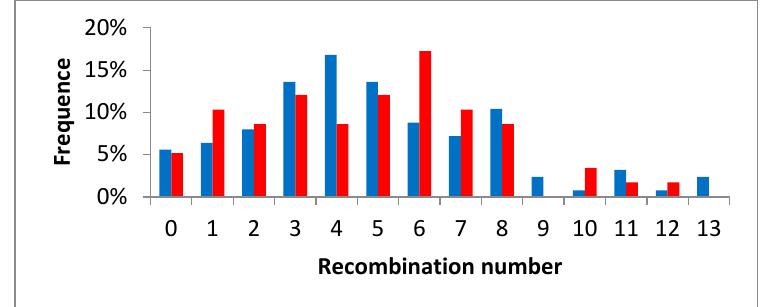
Figure 7. Distribution of the number of recombinations per gamete estimated from the citrumelo (blue) and citrandarin (red) gamete populations.